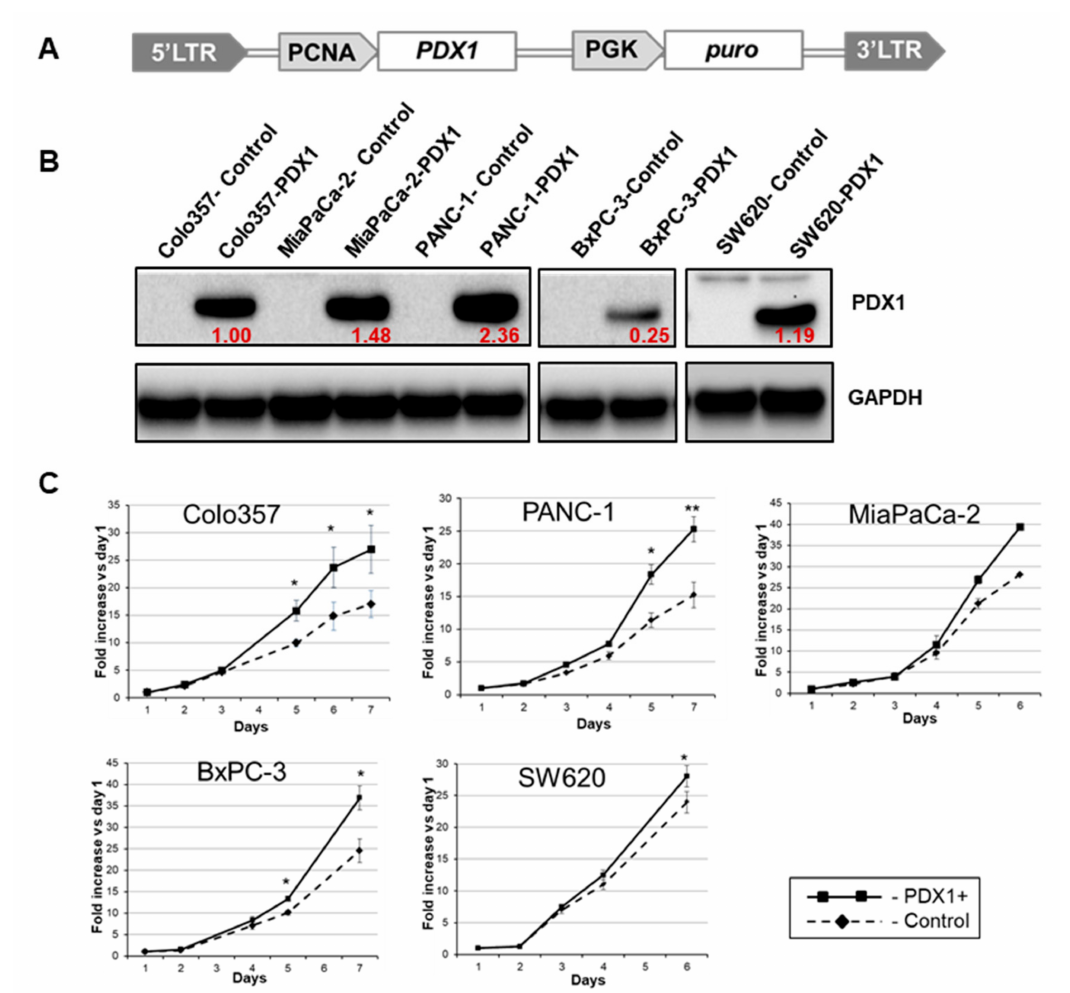
Figure 2. ( A ) Schematic of the lentiviral construct used to generate cultures of pancreatic cancer cells ectopically expressing PDX1. ( B ) Western blot analysis of PDX1 protein content in transduced pancreatic cancer cell lines BxPC-3, Colo357, MiaPaCa-2, PANC-1, and colon cancer line SW620. Red numbers indicate the relative amount of PDX1 protein in transduced Colo357-PDX1, MiaPaCa-2-PDX1, PANC-1-PDX1, BxPC-3-PDX1, and SW620-PDX1 cells. The values are given relative to the level of PDX1 in Colo357-PDX1 cells. GAPDH protein detection in cell extracts was used as a normalizing control. ( C ) Growth kinetics of PDX1-expressing cultures of pancreatic cancer cell lines and corresponding control cells by MTS test performing. Data are normalized relative to values on the first day of the experiment. Three independent experiments involving five–six time-point were conducted. Error bars refer to SD. Cancer cells transduced with lentivirus without the PDX1 gene were used as control. * p ≤ 0.05, ** p ≤